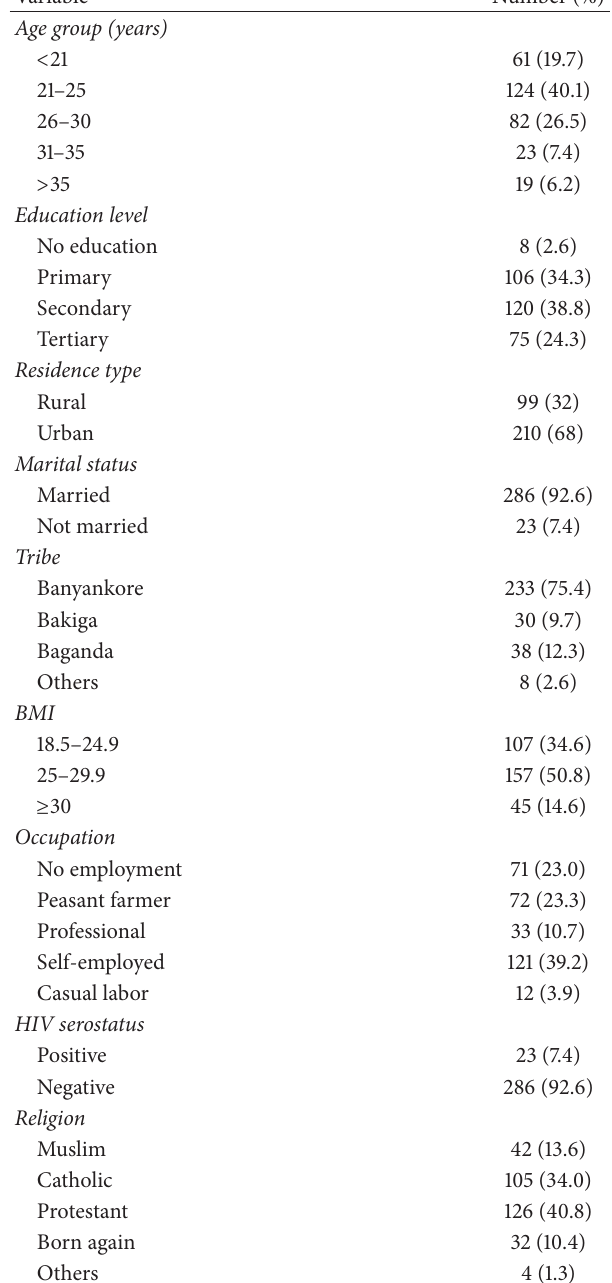
Table 1: Participants’ sociodemographic